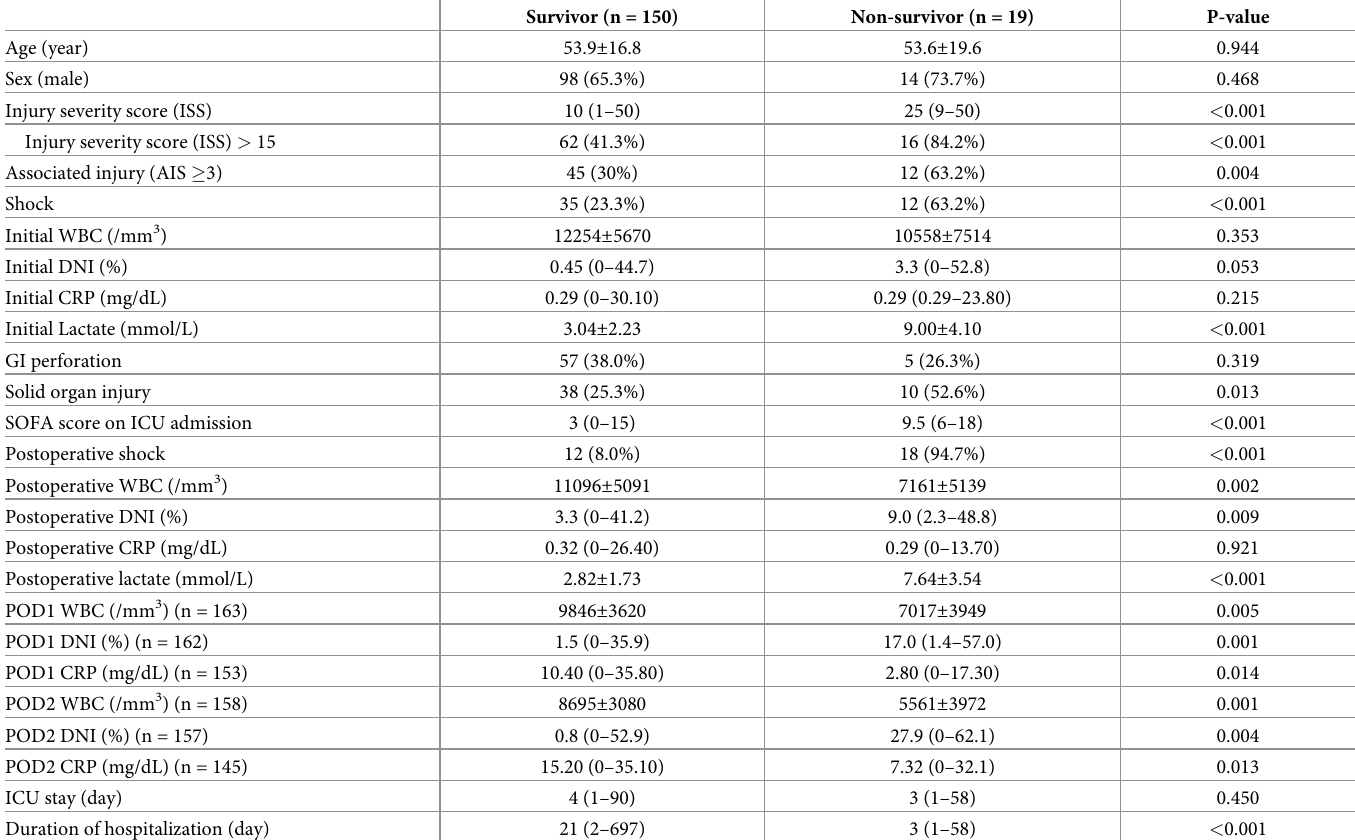
Table 3. Comparison between survivors and